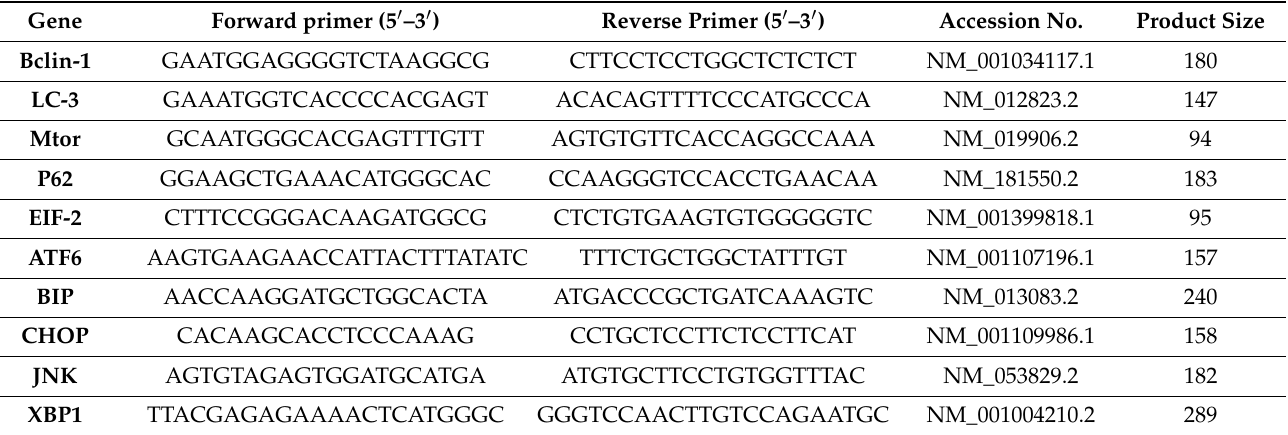
Table 1. Primer sequences, accession number, and product size for the quantitative RT-PCR for the analyzed genes in the pancreatic